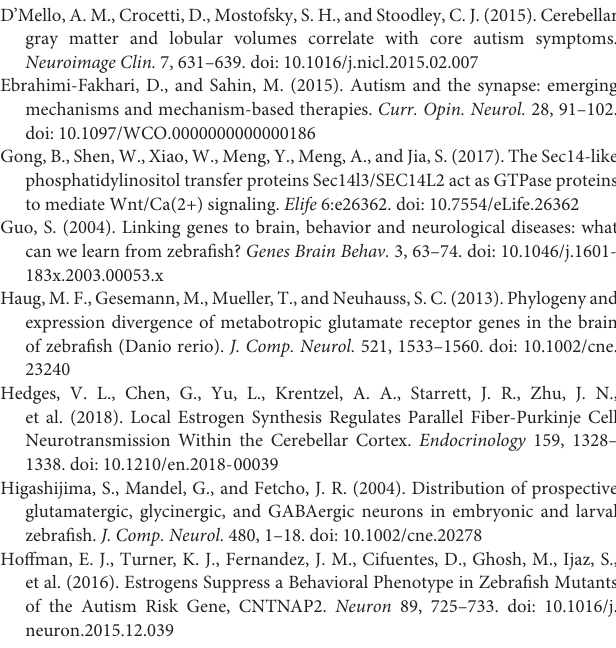
isoforms (arrows) were identified by the antibody only in necab2 + / + but not the necab2 − / − zebrafish. Supplementary Figure 6 | The expression of mGluR1 and the nature of neuronal subtypes expressing Necab2 in the larval zebrafish cerebellum. (A–A (cid:48)(cid:48)(cid:48) ) Confocal live imaging of the necab2 + / + larvae fish at 5 dpf in Tg( Pnecab2:EGFP ) and Tg( gad1b:DsRed ) background in the cerebellar gad1b-enriched area. The Necab2-expressing neurons strongly overlapped with the gad1b-positive neurons (arrowheads). Scale bar = 100 µ m (A) . The region in the dashed white box (A) was shown at higher magnification on the right (A (cid:48) –A (cid:48)(cid:48)(cid:48) ) . Scale bar = 10 µ m. (B–B (cid:48)(cid:48)(cid:48) ) Confocal live imaging of the necab2 + / + larvae fish at 5 dpf in Tg( Pnecab2:EGFP ) and Tg( vglut2a:DsRed ) background in the cerebellar gad1b-enriched area. The Necab2-expressing neurons overlapped with the vglut2a-positive neurons (arrowheads). Scale bar = 100 µ m (B) . The region in the dashed white box (B) was shown at higher magnification on the right (B (cid:48) –B (cid:48)(cid:48)(cid:48) ) .